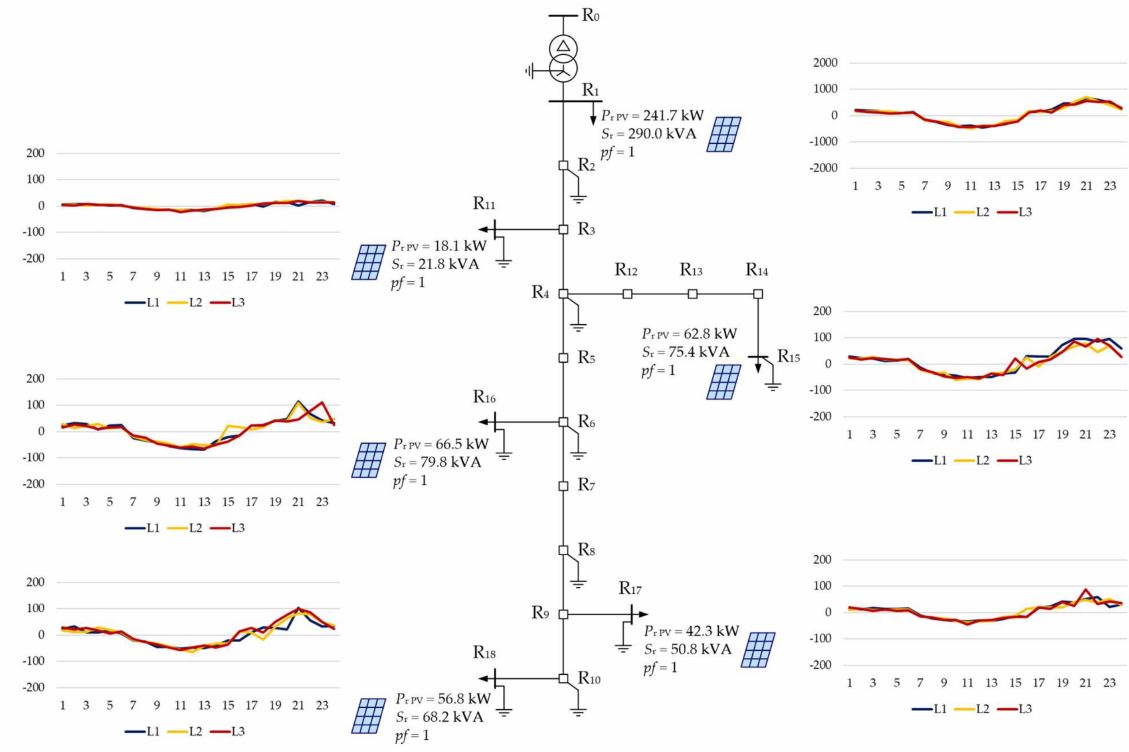
Figure A8. Daily simulation results for variant V7: phase currents